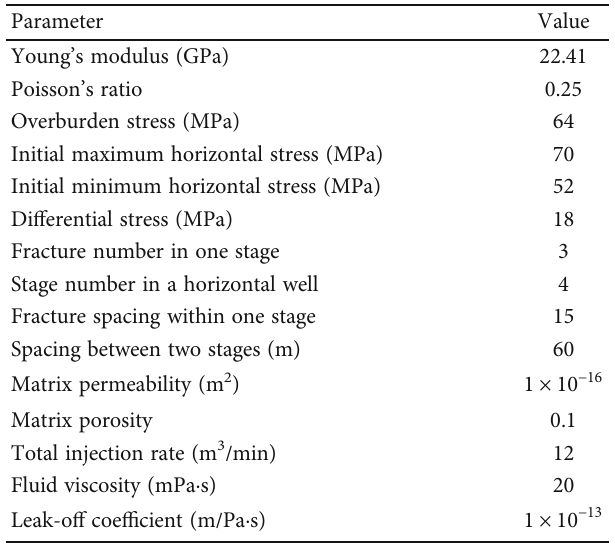
Table 1: Parameters for the base case of hydraulic fracturing modeling.